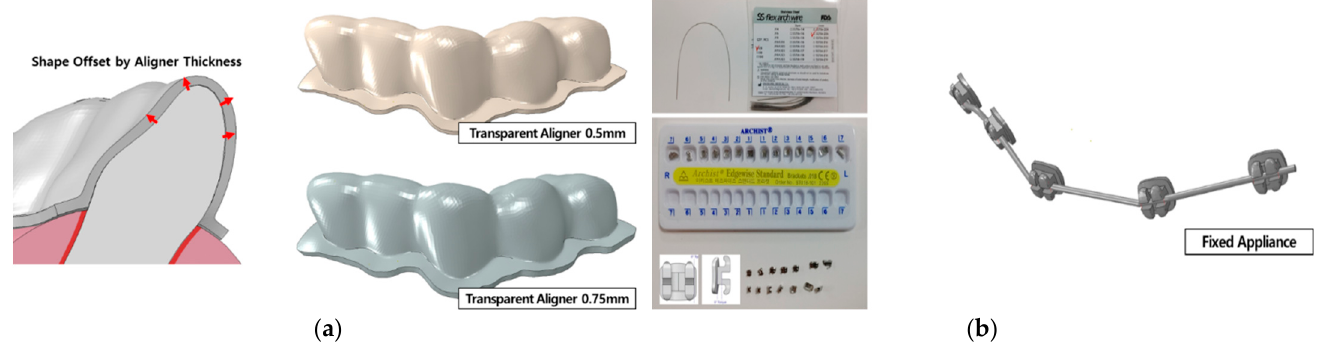
Figure 3. Orthodontic appliance finite element models. ( a ) Model developed by offsetting the outer shape of the crown and gingiva with 0.5-mm and 0.75-mm-thick transparent aligners; ( b ) Model developed through reverse engineering of previously commercialized edgewise standard bracket and arch-wire.